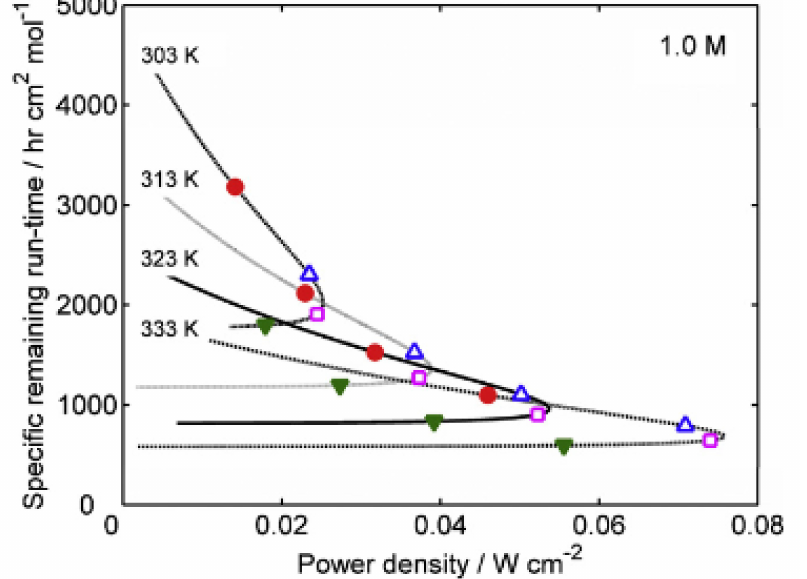
Figure 7. The specific remaining runtime under various operating temperatures and a fuel concentra- tion of 1.0 M. ( • ) 0.5 V, ( ∆ ) 0.4 V, ( (cid:3) ) 0.3 V, and ( ∇ ) 0.2 V